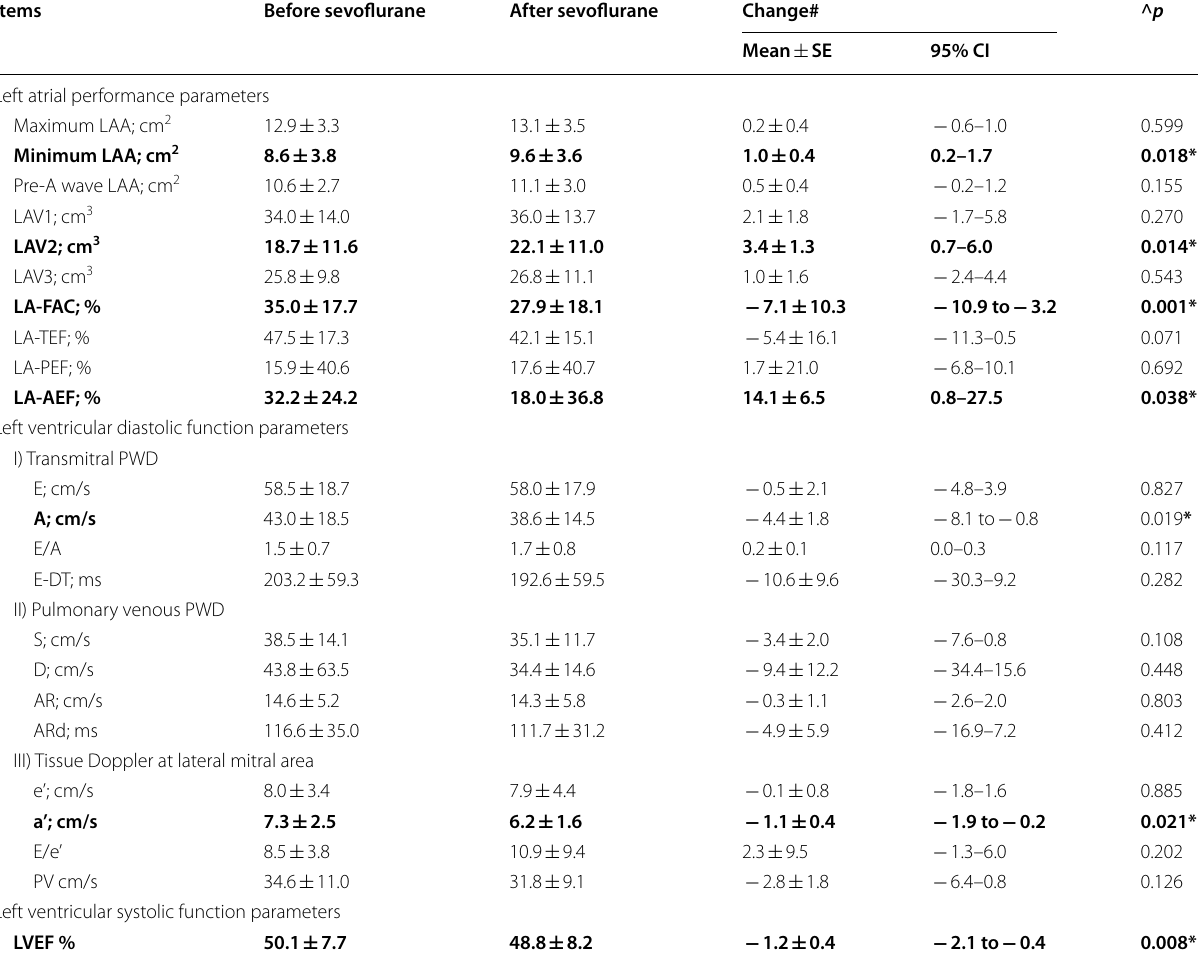
Table 2 Parameters among the studied